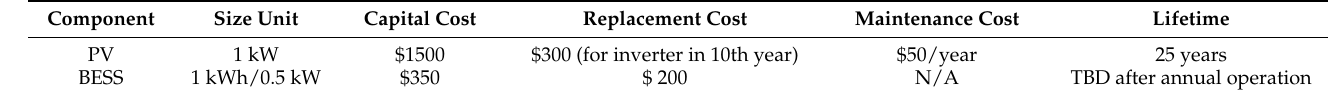
Table 4. Rooftop PV and BESS characteristics for the optimal sizing